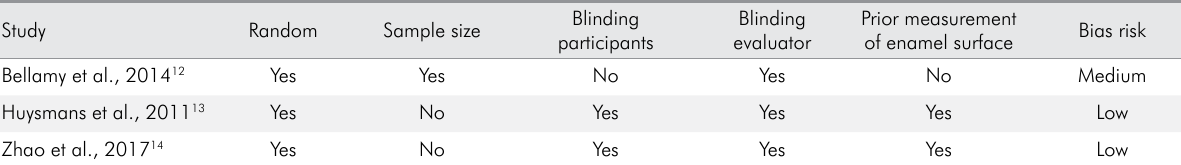
Table 3. Assessment of the risk of bias of included studies in the systematic review. Study